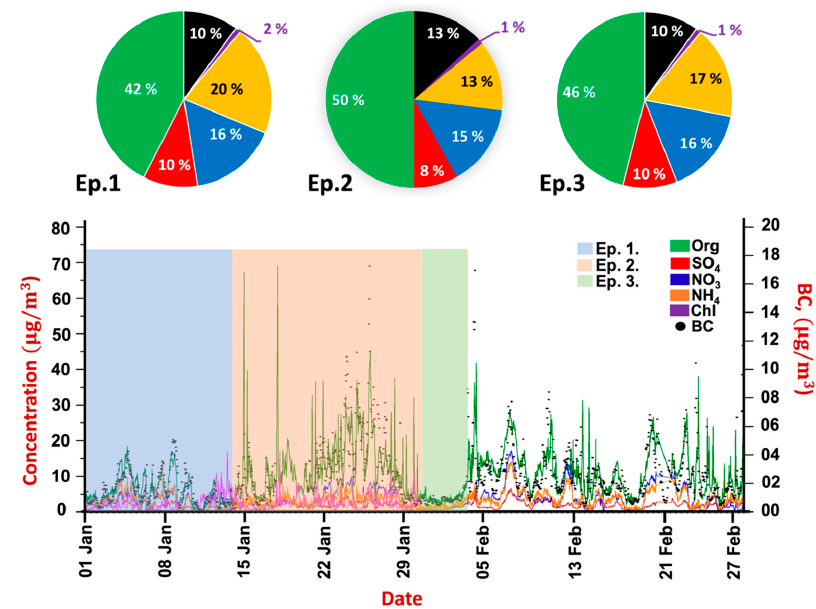
Figure 2. Temporal variation of species (organics, sulfate, nitrate, ammonium, and chloride) and aerosol black carbon. The pie charts show the fractional abundances of individual BC and ACSM species averaged over the episodes.